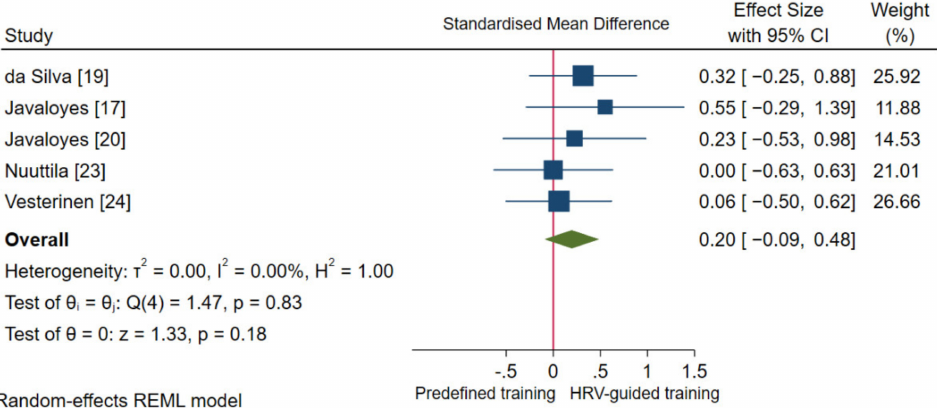
Figure 6. Forest plot of standardized mean difference indices for endurance